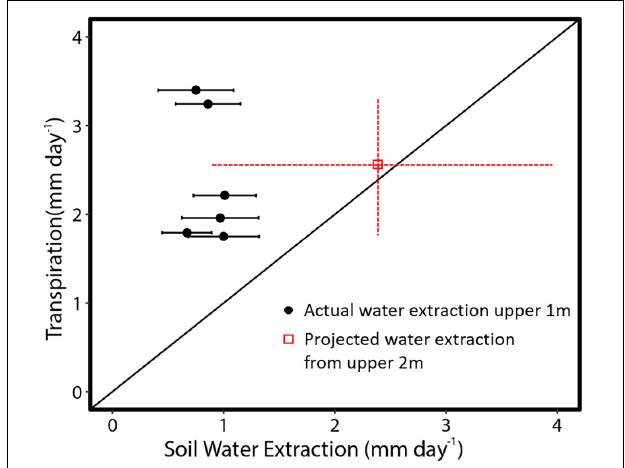
FIGURE 10 | Average daily dry season transpiration for six adjacent plots in the central Amazon in comparison to mean measured or projected ( Table 3 ) soil water extraction rates. Projected water extraction from the upper 2 m is based on a logarithmic fit ( Figure 6 ). Black line is the 1:1 line. Red error bars show the range of transpiration and confidence intervals of projected water extraction from the upper 2 m of the soil